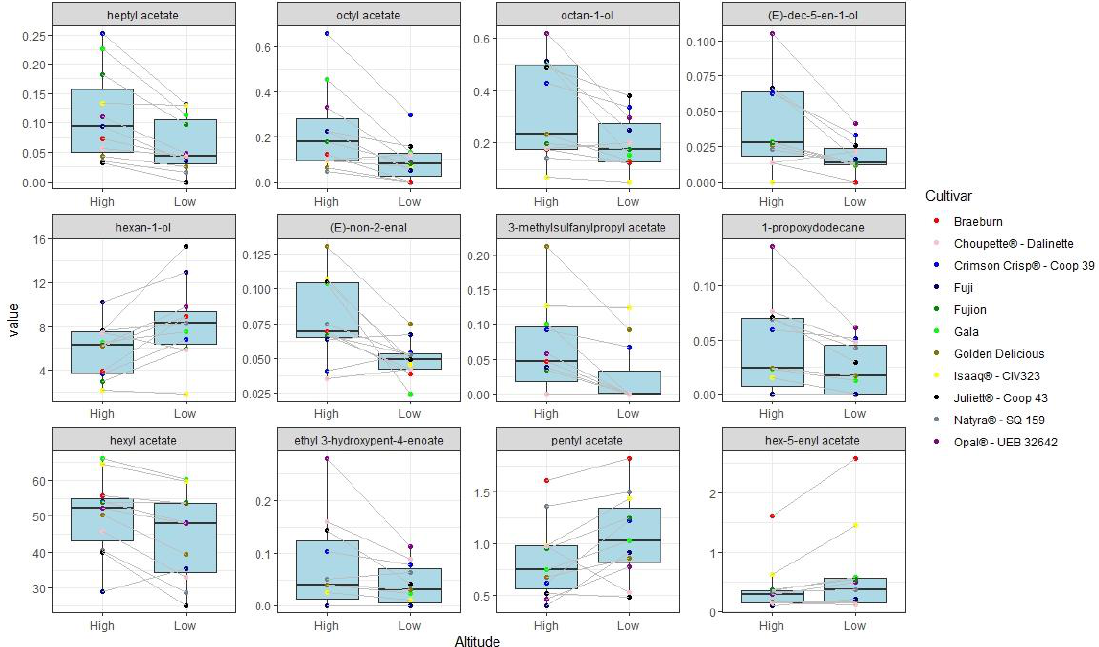
Figure 1. Boxplots according to statistical Wilcoxon signed rank test. Values represent the height percentage and altitude represents the different pedoclimatic locations (High = 650 m, Low = 225 m).